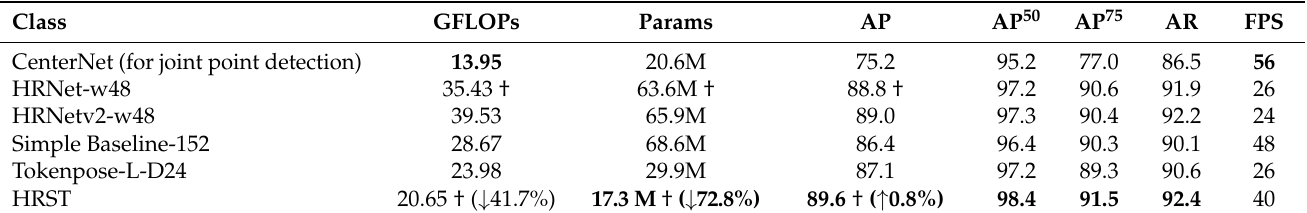
Table 5. Results of different joint point detection models on the ATRW test set. The relevant indicators of this table are consistent with those in Table 4.